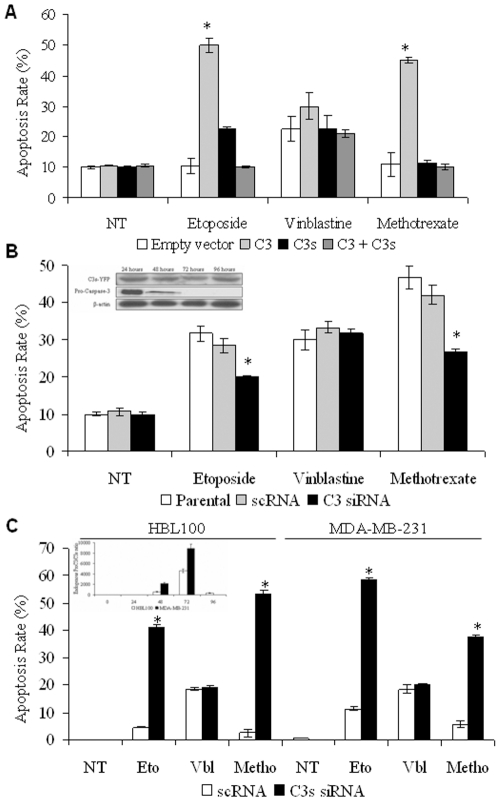
Caspase-3s inhibits drug-induced apoptosis.
A. MCF-7 cells were stably transfected with GFP vector (white), procaspase-3-GFP (light grey), caspase-3s-YFP (black) or with C3-GFP and C3s-YFP (dark grey) and treated with etoposide, vinblastine or methotrexate for 48 H. B. HBL100 WT cells (white) were transfected either with scRNA (grey) or with siRNA against procaspase-3 (black). The efficiency of procaspase-3 extinction is shown in the small inset. Apoptosis was next induced by etoposide, vinblastine or methotrexate and detected by flow cytometry. Asterisks correspond to p<0.01. C. HBL100 and MDA-MB-231 cells (white) were transfected either with scRNA (white) or with siRNA against caspase-3s (black). The efficiency of caspase-3s extinction is shown in the small inset. Apoptosis was next induced by etoposide, vinblastine or methotrexate and detected by flow cytometry. The drug used yields in panel C were 10 fold inferior than the IC50 used in panel B, explaining the differences between controls of panels B and C. Asterisks correspond to p<0.01.